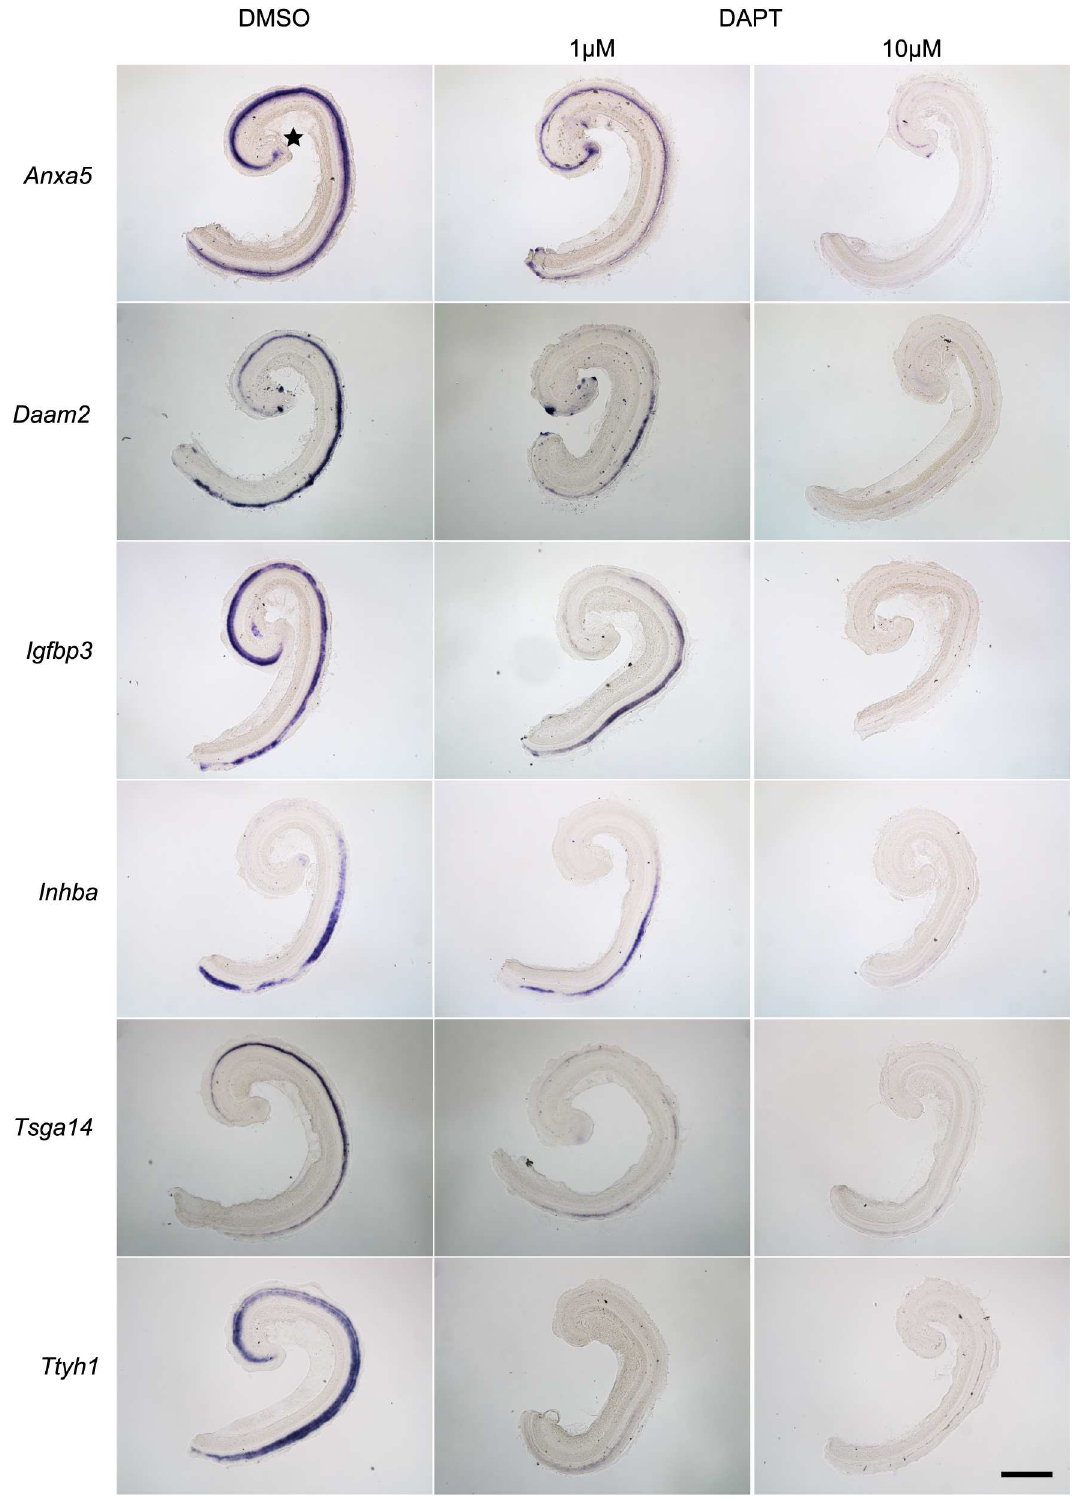
Fig 3. Gene expression changes in P0 supporting cells in response to Notch inhibition. Demonstration of rapid down-regulationby in situ hybridizationof six supporting cell-specific genesin P0 cochleasafter 24 hours of culture in DAPT versus DMSO controls. Scale Bar: 500 μ m. Star: apex